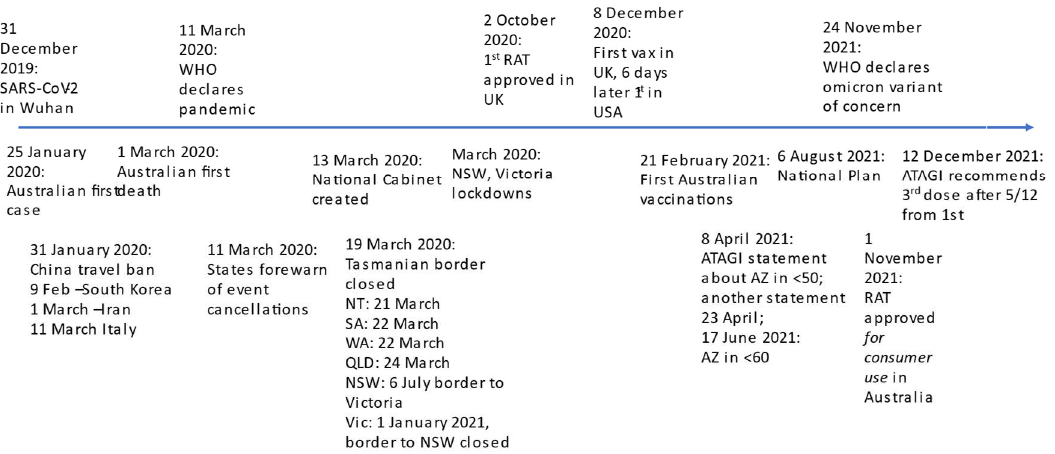
Figure 1. Key COVID-19 dates. Source: Author’s